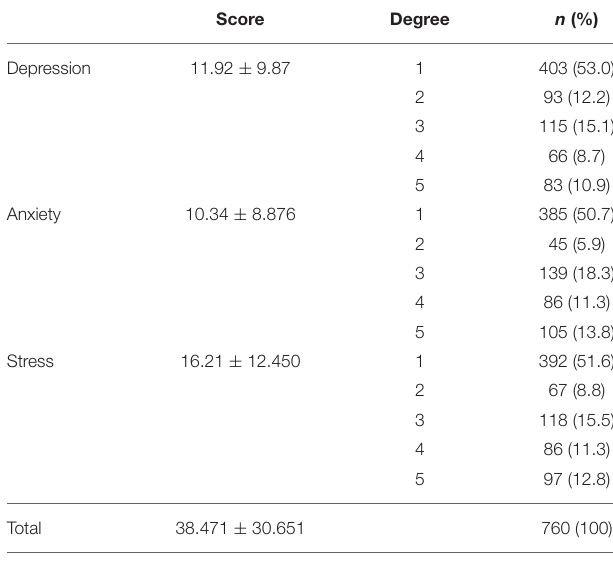
TABLE 1 | Sample characteristics ( N = 760).